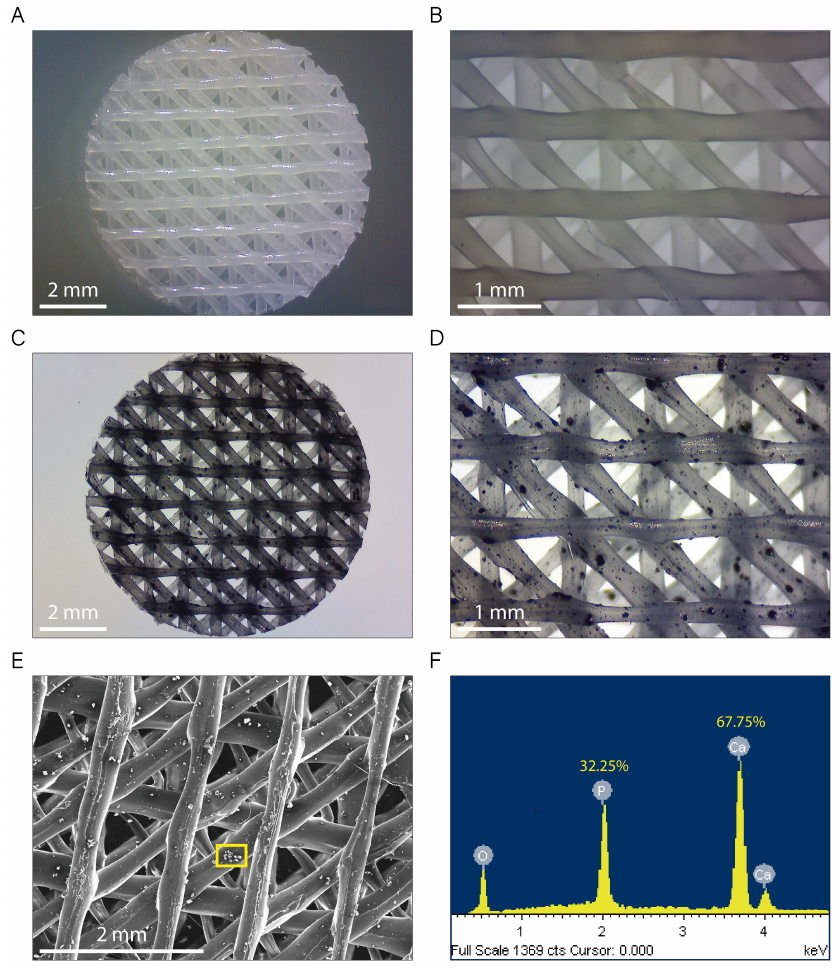
Figure 2. Images of both ( A , B ) PCL and ( C , D ) PCL/ β -TCP scaffolds taken with a stereomicro- scope at different magnifications. The β -TCP microparticles were stained with nigrosine for clarity. ( E ) Micrograph acquired with SEM showing a magnification of the PCL/ β -TCP scaffold and ( F ) its corresponding EDX spectrum. The researched area is depicted as a yellow